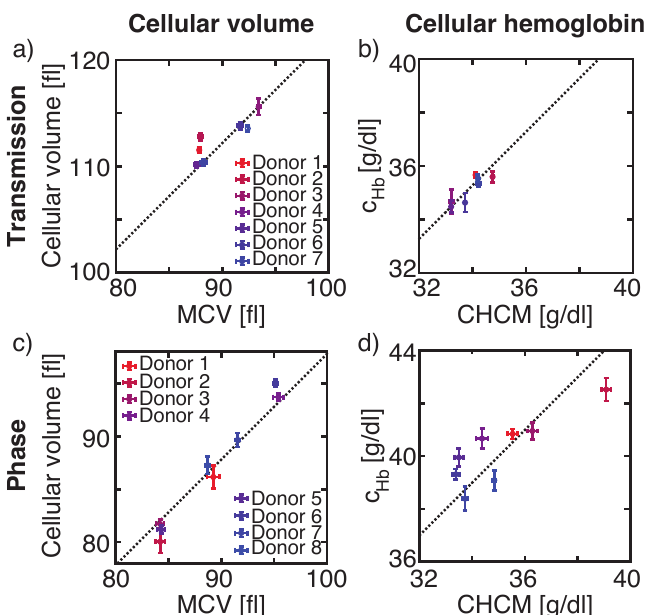
Figure 4. Comparisons of the cellular volume of our measurements to the reference value mean corpuscular volume (MCV) obtained from ADVIA 2120i for transmission ( a ) and phase images ( c ) and of the microscopic measured cellular hemoglobin concentration to the reference value corpuscular hemoglobin concentration mean (CHCM) obtained from ADVIA 2120i for transmission (I min ) ( b ) and phase images (OH mean ) ( d ). Same set of donor samples were used for V and Hb measurements in transmission images and another set of donors was used for V and Hb values calculated from phase